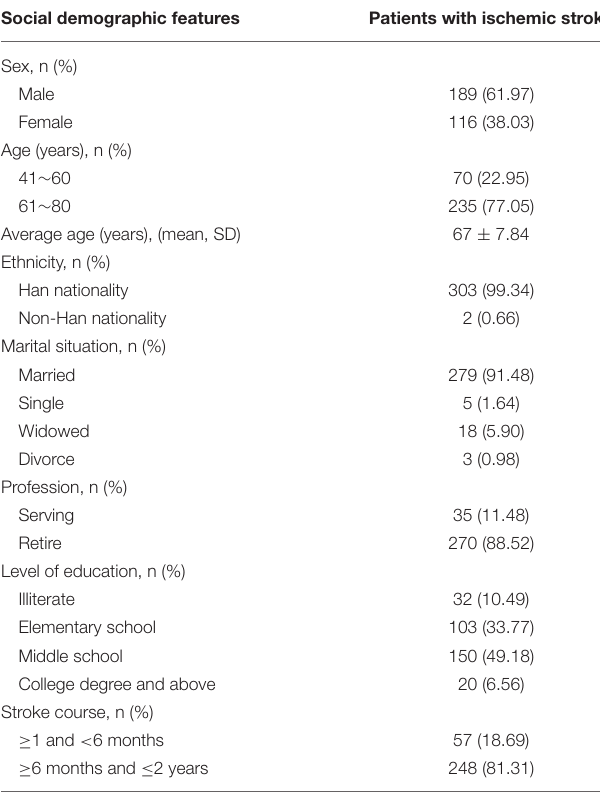
TABLE 1 | The sociodemographic features of ischemic stroke patients. Social demographic features